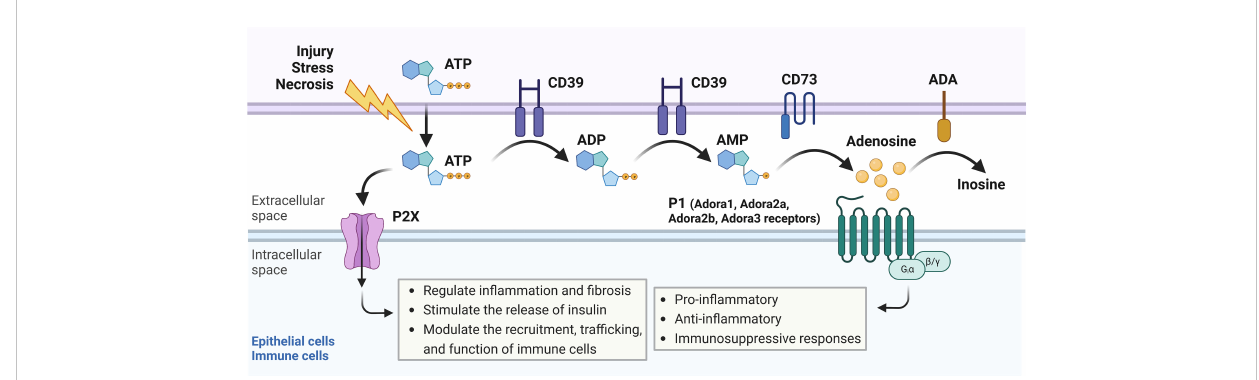
FIGURE 1 Adenosine signaling pathway overview. In response to cellular injury, stress, or necrosis, adenosine triphosphate (ATP) is released to the extracellular space, where it can signal through P2X receptors on epithelial or immune cells to regulate in fl ammation and fi brosis, stimulate the release of insulin, or modulate recruitment, traf fi cking, and function of immune cells. Extracellular ATP can also be converted by CD39, an ectonucleotidase enzyme, into adenosine diphosphate (ADP) or adenosine monophosphate (AMP). AMP can then be converted into adenosine by CD73, another ectonucleotidase enzyme. Adenosine binds to P1 receptors including Adora1, Adora3, Adora2a, or Adora2b, which can all be expressed on epithelial, stromal, or immune cells. Activation of the P1 receptors results in pro-in fl ammatory, anti-in fl ammatory, or immunosuppressive responses depending on which P1 receptor is involved and which intracellular signaling pathways are activated downstream. Adenosine can also be converted to inosine by adenosine deaminase (ADA) in an irreversible termination